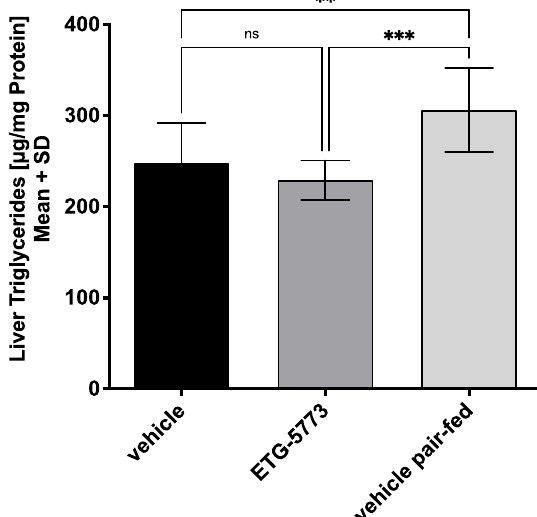
Figure 3. Liver triglycerides are reduced in obese mice treated with ETG-5773. Triglyceride content in the livers of DIO mice after the 28-day treatment period. Animals were treated orally twice a day with 15 mg/kg ETG-5773 or with the corresponding vehicle or vehicle in the pair-fed group ** p < 0.01, *** p < 0.001, ns: non-significant, ANOVA mean SD, n = 12 vehicle and ETG-5773, n = 8 pair-fed.